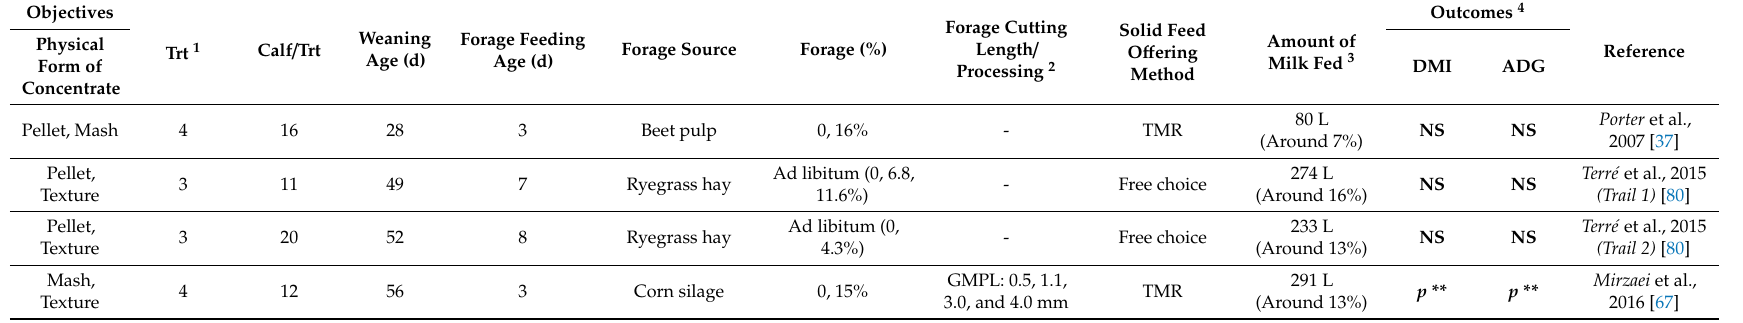
Table 5. A summary of studies on forage inclusion in dairy calves based on di ff erent physical forms of